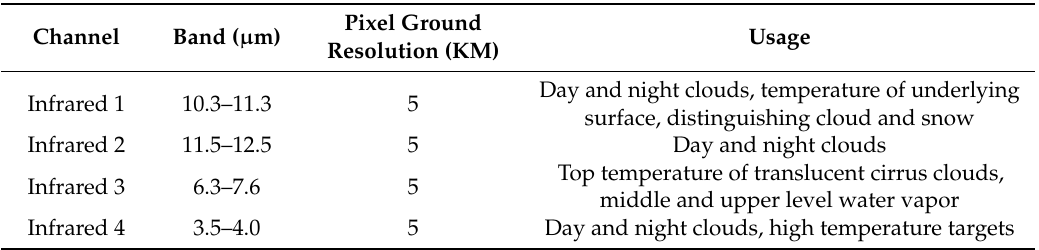
Table 1. Satellite radiometer